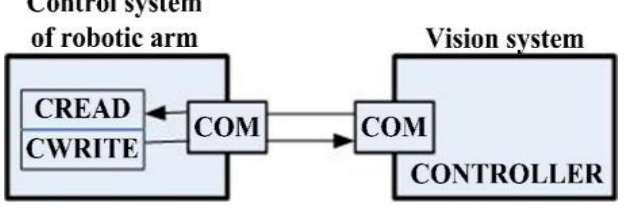
Figure 3. The setting of serial interface communication.